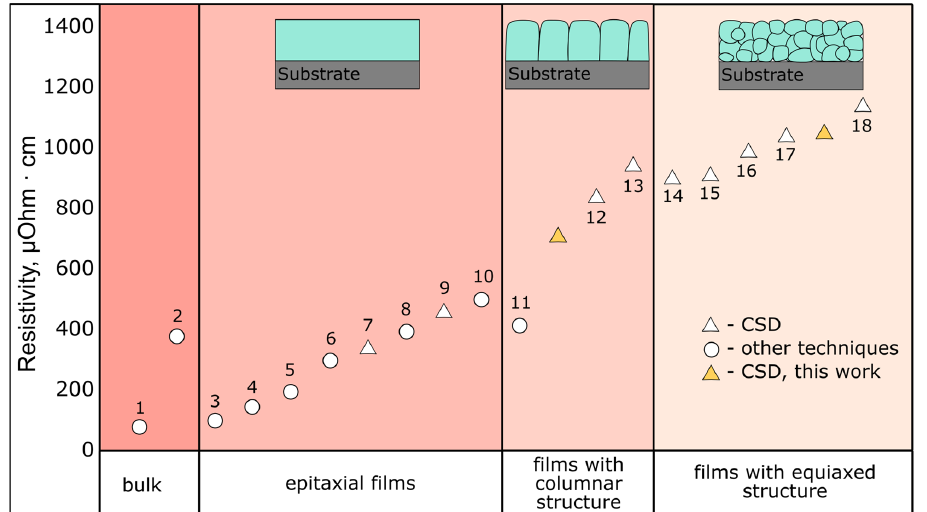
Figure 17. Electrical resistivity of LNO with various internal structures. Values of the resistivity marked with numbers 1–18 are taken from the following references: 1—[88], 2—[89], 3—[28], 4—